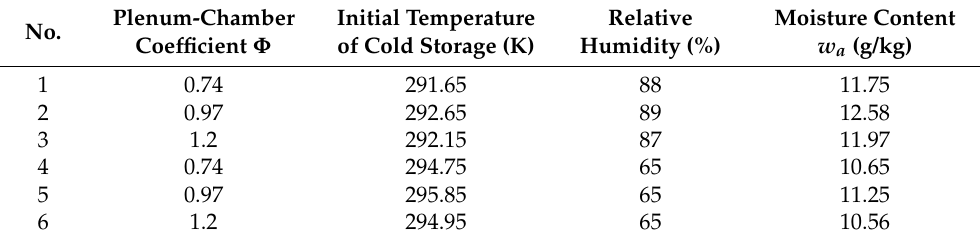
Table 2. Initial parameters in cold storage under high and low